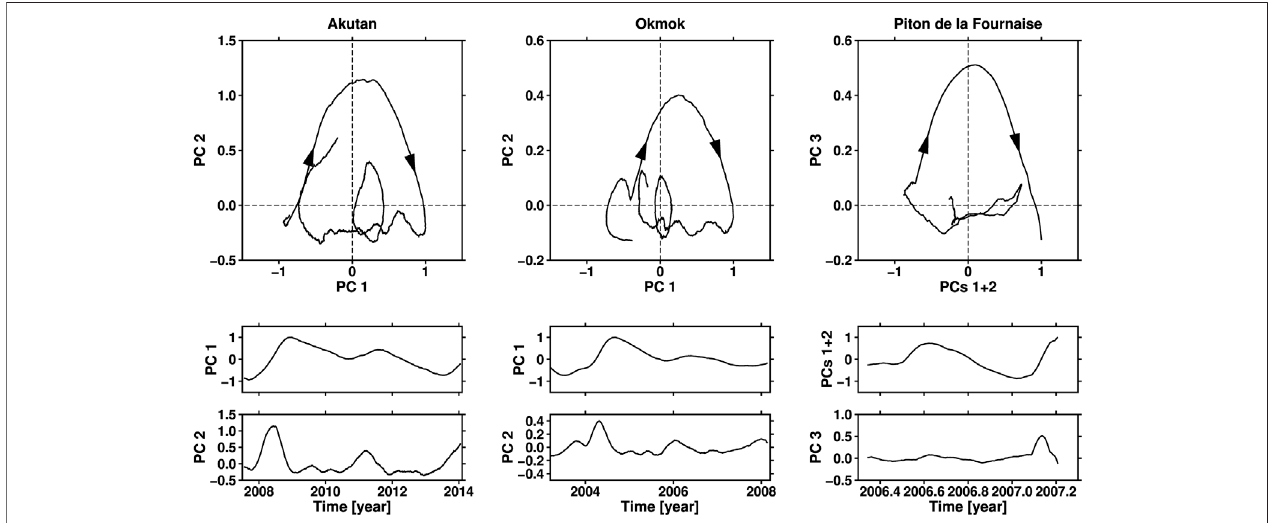
FIGURE5 | Phase portrait reconstructions that re fl ect the dynamicsofthe three volcanic systemsunder study. The (A) are the actual phase portraits, while the (B) below each phase portrait show the two PCs (for Akutan and Okmok) or three PCs (for PdF) used to reconstruct the trajectories in the phase